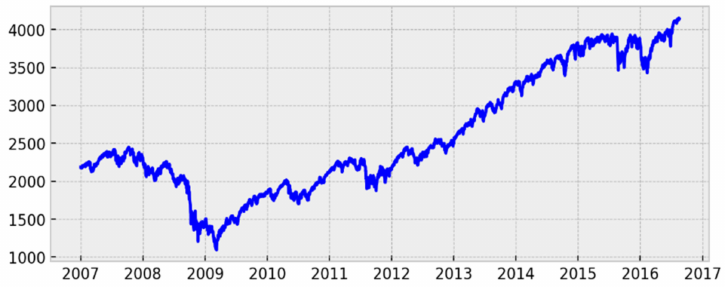
Figure 6. Price chart of the S&P 500 total return